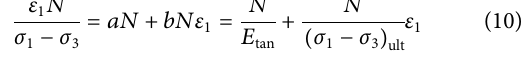
Frontiers in Earth Science |